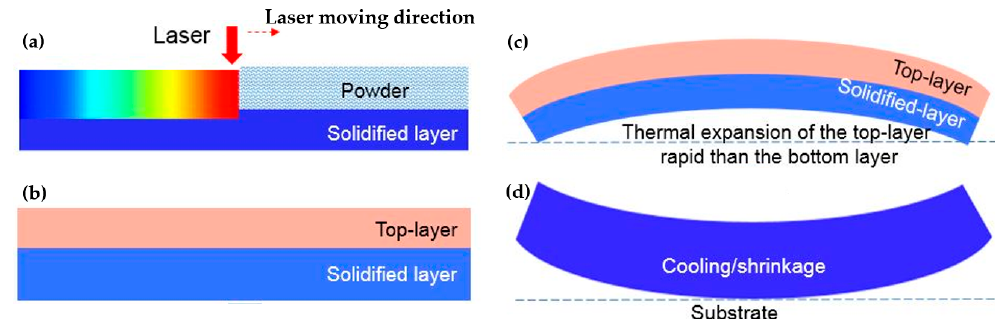
Figure 4. Temperature gradient mechanism [11]: schematic of the SLM processing ( a ) created a new layer on other solidified layers ( b ), thermal expansion generated by heated new layer ( c ) and shrinkage process during cooling ( d ).